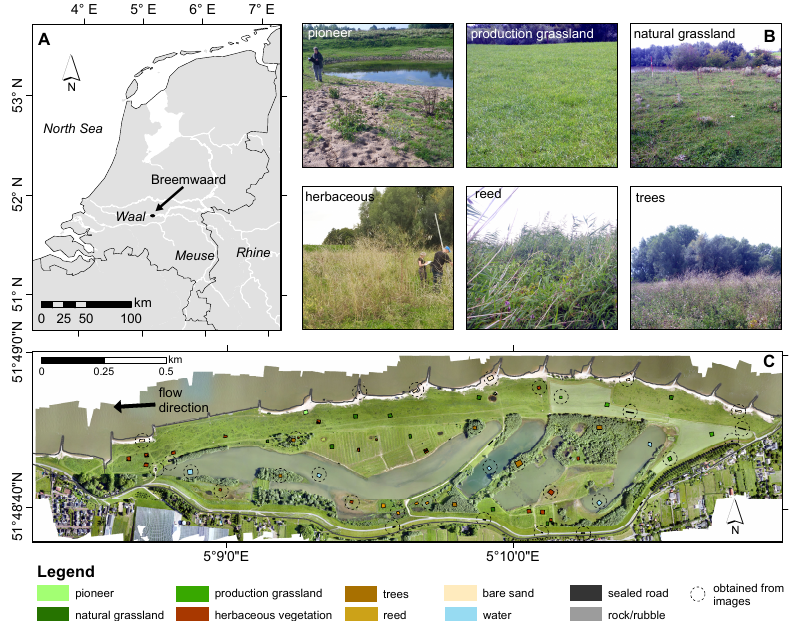
Figure 1. Breemwaard study area on the Southern bank of the river Waal. ( A ) Location in the Rhine Delta; ( B ) Field impressions of typical vegetation in the study area; ( C ) Orthophoto of June with classified reference polygons. Polygons marked with a dotted circle were obtained from the imagery and the remaining polygons were obtained from the